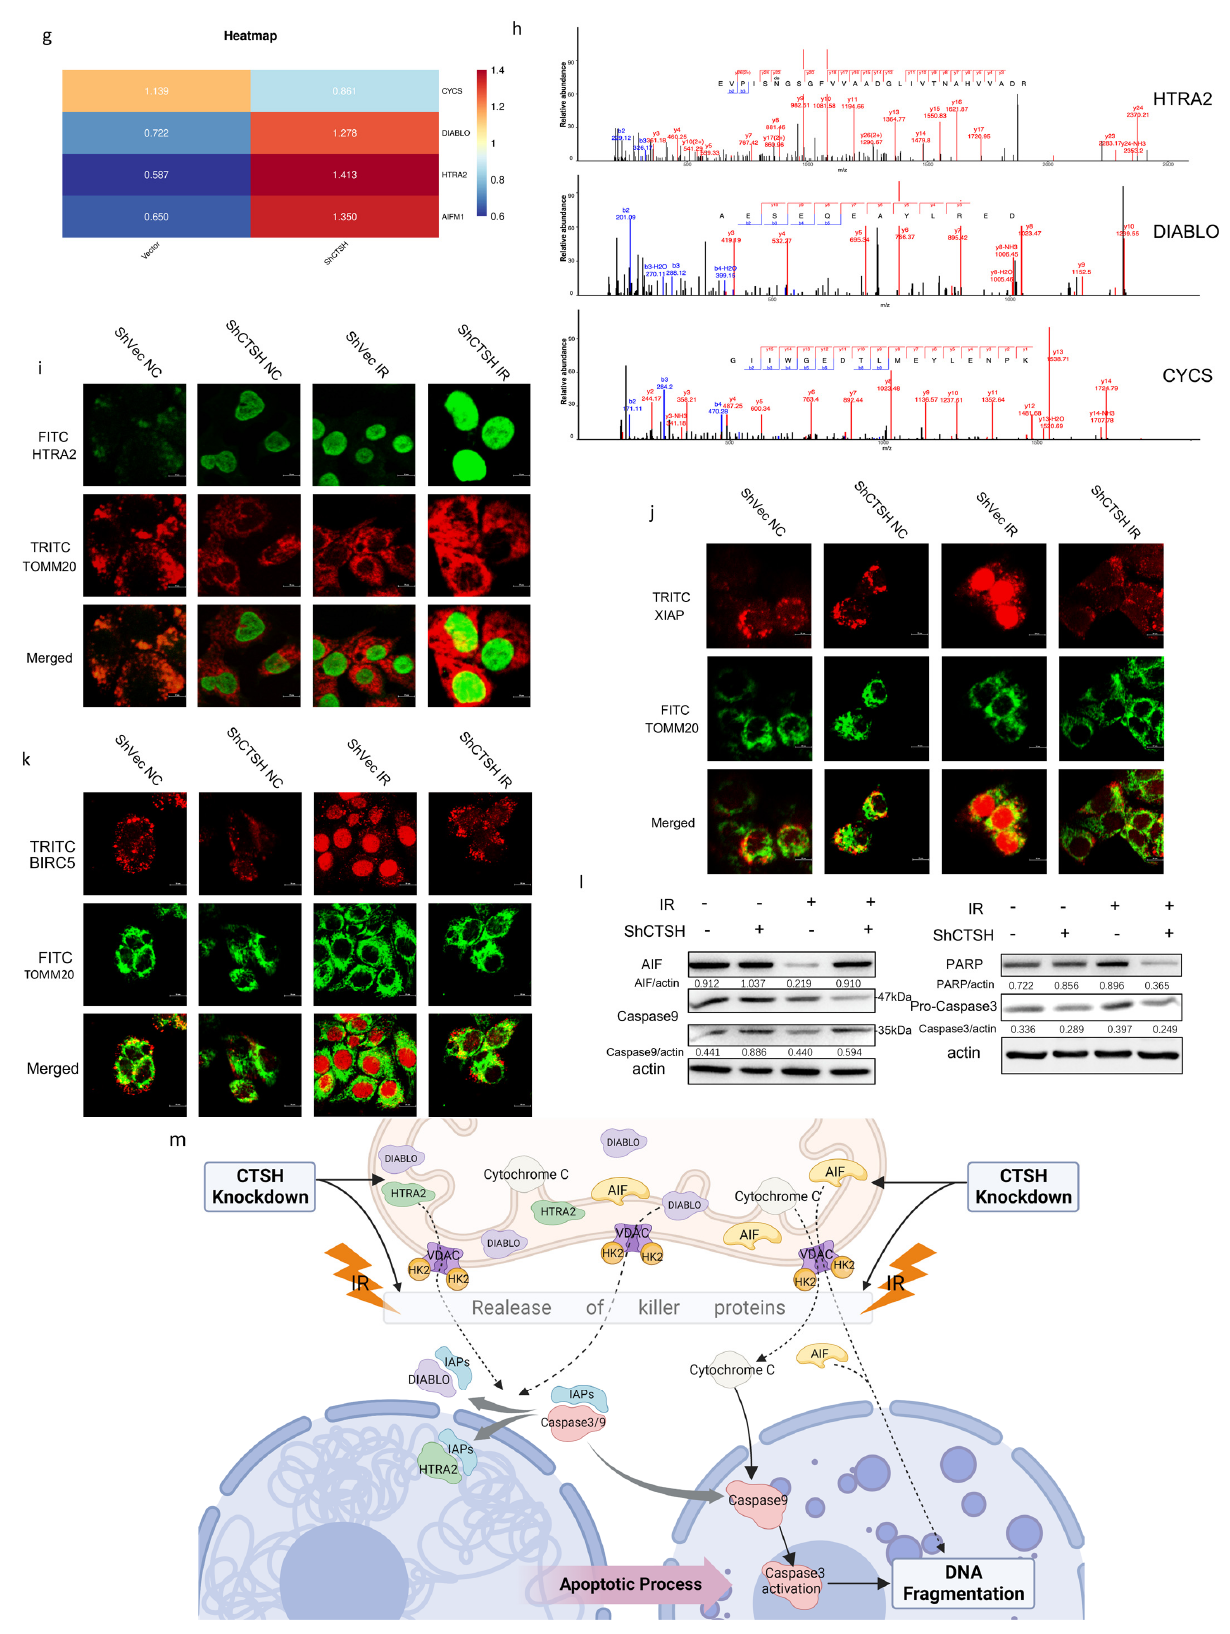
Figure 4. Knockdown of CTSH and Enhanced Aerobic Respiration Promoted Radiation-induced Apoptosis via IAP Inhibition and AIF Signaling. ( a , b ) Flow cytometry analysis of Annexin